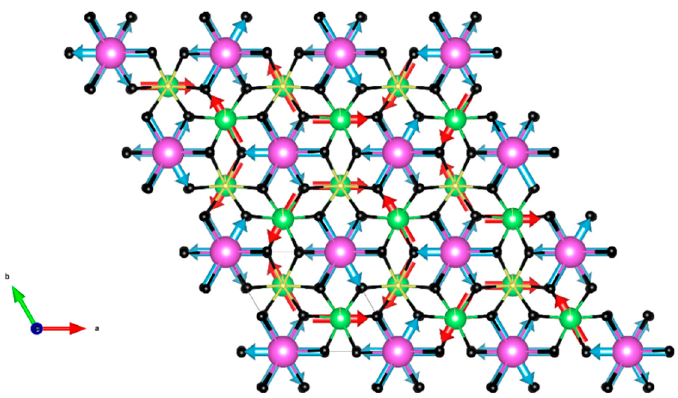
Figure 6. The ball-and-stick representation [20] of the crystal structure of GdFeTeO 6 . Purple, green, gray and black spheres are Gd, Fe, Te and O ions, respectively. Blue and pink arrows highlight the clockwise and anticlockwise arrangements of spins in different magnetoactive layers. Supplementary Materials: The following are available online at https://www.mdpi.com/article/10.3390/ma14205954/s1, Figure S1. Comparison of the two XRD patterns of nominal “GdFeTeO 6 ” taken in CuK α radia-tion. Upper panel: Relatively pure phase prepared from oxides for 48 h at 700 °C [5]. Lower pan-el: mixed phase prepared by the semi-wet method for 56 h at 750 ° С with three intermediate re-grindings (this work)., Figure S2. Correlation between crystal radii [6] of RE 3+ and hexagonal subcell parameters of REFeTeO 6 . Red diamonds, a; blue triangles, c/2; RE = La [1, 3, 4], Pr, Nd, Sm [4], and Gd (this work); green circles, same from Reference [5]., Figure S3. (a) Effect of changing UGd (eV) for the energy differences of one AFM and 3 FiM states with respect to the FM state. Changes of Gd UGd in the legend, with fixed UFe = 4 eV. (b) Energy difference between FiM1 and FM states. Effect of changing UGd and UFe, and comparison with HSE calculations (black line)., Figure S4. The comparison of Monte-Carlo calculations (solid lines) with the experimental tem-perature dependencies of mag- netic susceptibility (T) (left panel) and specific heat Cp(T) (right panel)., Table S1. Phase analysis results and hexagonal lattice parameters of GdFeTeO 6 samples prepared by various methods., Table S2. Details of the data collection and structure refinement., Table S3. Atomic coordinates and dis- placement parameters in GdFeTeO 6 , space group 𝑃3(cid:3364)1𝑐 ., Table S4. Atomic coordinates and displace- ment parameters in GdGaTeO 6 , space group 𝑃3(cid:3364)1𝑐 .